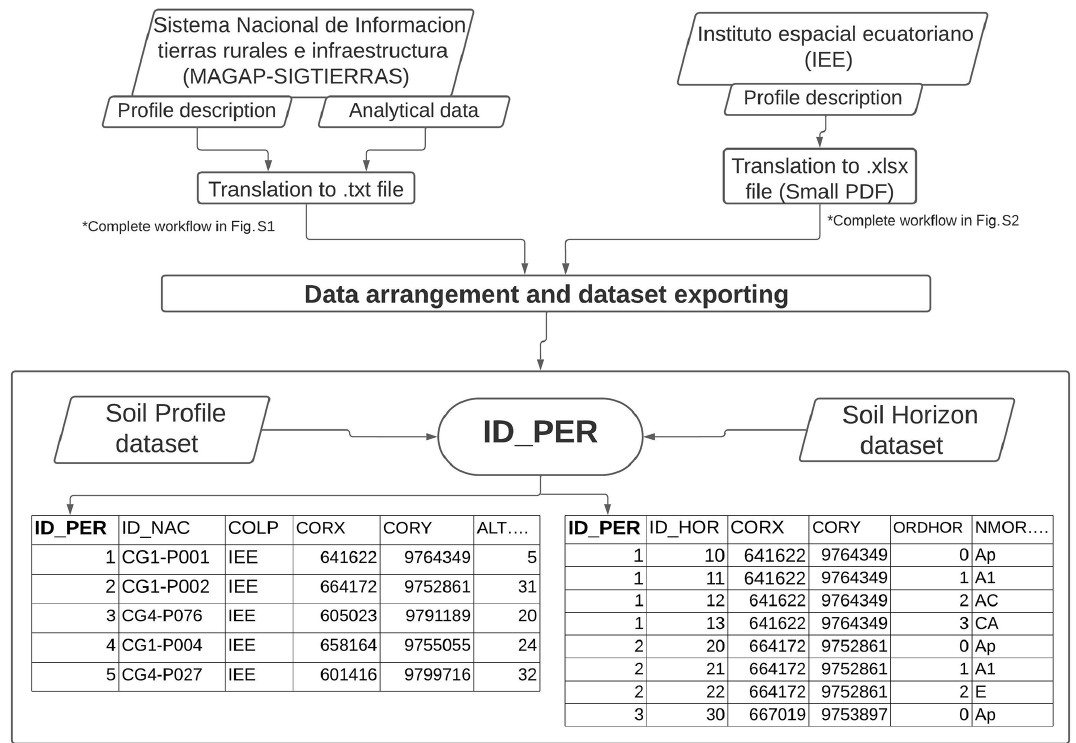
Figure 2. Overview of the workflow for extracting data and structure database harmonization. The following abbreviations are used in the figure: ID_PER – profile identifier, ID_NAC – profile identifier in the provenance collection, COLP – source project, CORX – longi- tude coordinates, CORY – latitude coordinates, ALT – altitude, ID_HOR – horizon identifier, ORDHOR – horizon number, and HMOR – morphological